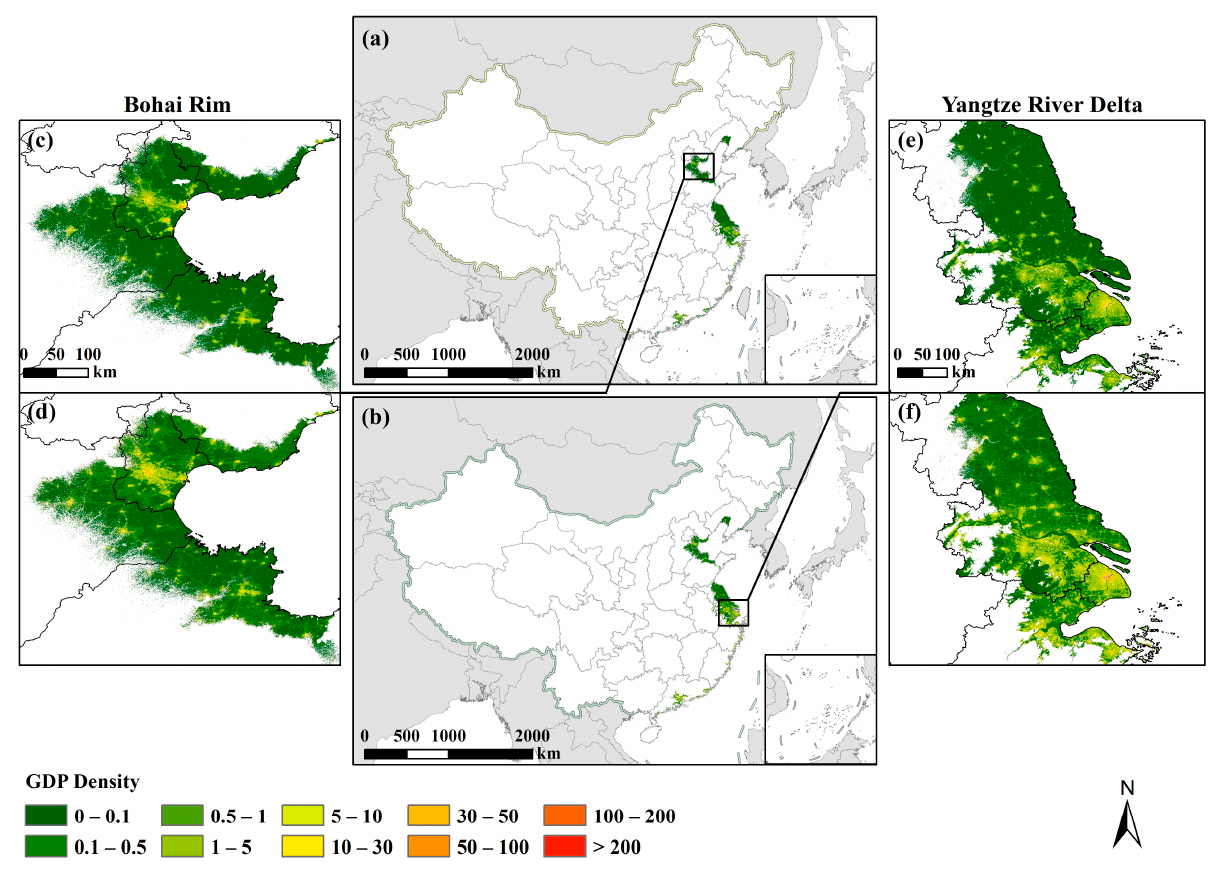
Figure 4. Total-GDP distribution of China’s LECZ in 2010 ( a , c , e ) and 2019 ( b , d , f ) (unit: million CNY/ha). Table 2. GDP statistics in the LECZ of provinces of